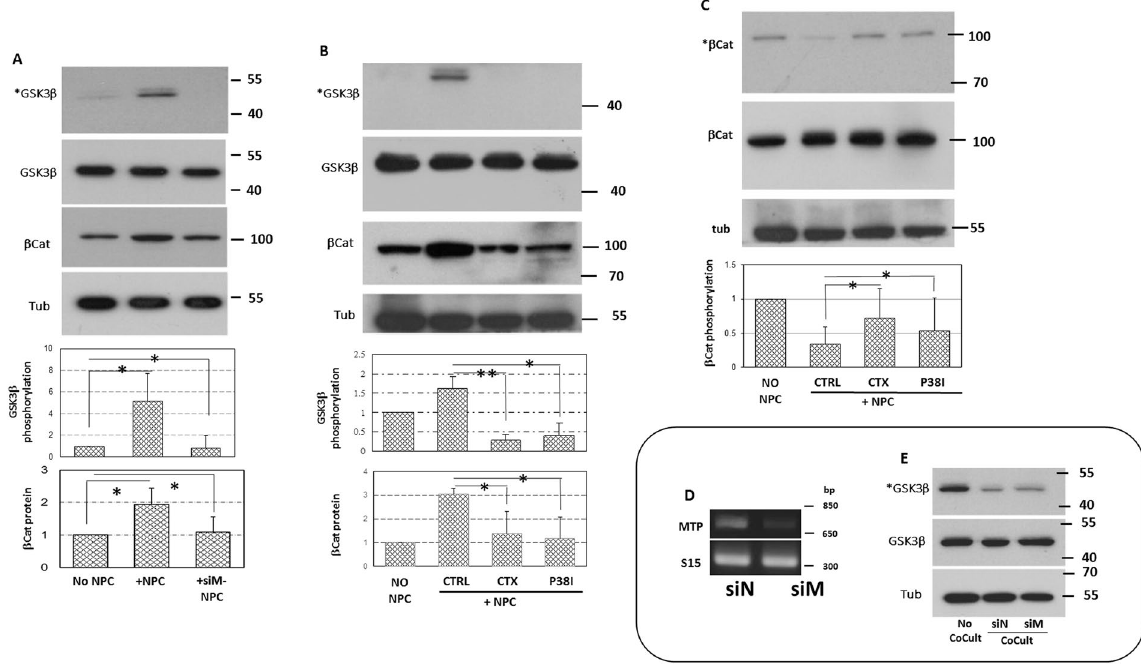
Figure 1. MTP-dependent endothelial GSK3 β inactivation- β catenin activation is downstream of p38MAPK activation and sensitive to CTX. ( A ) Western blot of endothelial GSK3 β and β -catenin. The bEnd cells were either cultured alone (No NPC), in contact co-culture with NS/P cells ( + NPC) or in contact co-culture with MTP-knockdown NS/P cells ( + siM-NPC). Total GSK3 β protein (GSK3 β ), the serine 9 phosphorylated GSK3 β protein ( * GSK3 β ) and total β -catenin protein ( β Cat) were examined in bEnd cells. ( B ) Western of total GSK3 β protein (GSK3 β ), the phosphorylated GSK3 β protein ( * GSK3 β ) or total β -catenin protein ( β Cat) in bEnd cells either cultured alone (NO NPC) or in contact co-culture with NS/P cells ( + NPC) in the absence (CTRL) or in the presence of CTX (CTX) or p38MAPK inhibitor (P38I). ( C ) Western of phosphorylated and total β -Catenin ( * β Cat, β Cat respectively) in bEnd cells cultured under the same conditions as in “B”. Bar graph showing Western blot densitometry data collected from 3–5 independent experiments. The GSK3 β phosphorylation was normalized to total GSK3 β . Expression level of β -catenin total protein was normalized to α -tubulin (Tub). In panel C, β -catenin phosphorylation level was normalized to total β -catenin protein. All were compared to cells cultured without NS/P cells which were set to 1. ( D) RT-PCR of MTP in NS/P cells transfected with either control siRNA (siN) or MTP-siRNA (siM). ( E ) Western blot of GSK3 β protein (GSK3 β ) or the phosphorylated GSK3 β protein ( * GSK3 β ) in NS/P cells. NS/P cells were collected from the experiments in “A”. The molecular sizes of protein markers in kDa were labeled on the right edge of each Western